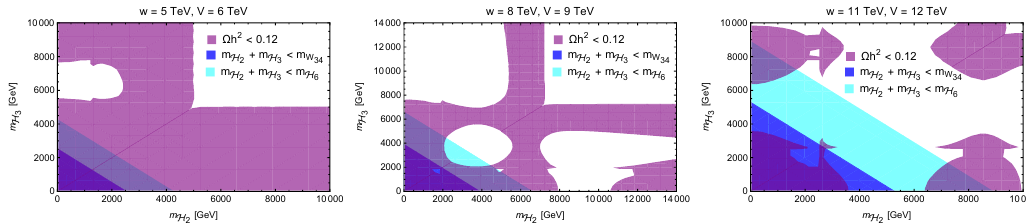
Figure 10 . The total relic density contoured as a function of ( m stable regime is also included, according to the several choices of w; V